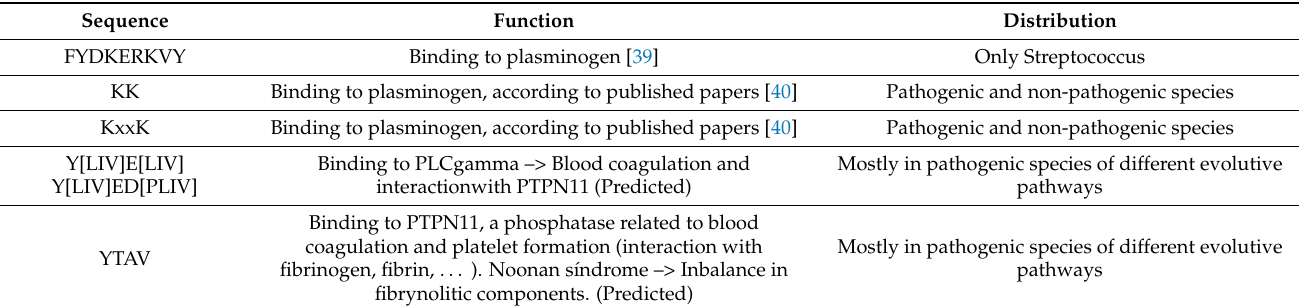
Table 1. Plasminogen binding motifs in Streptococcus pneumoniae